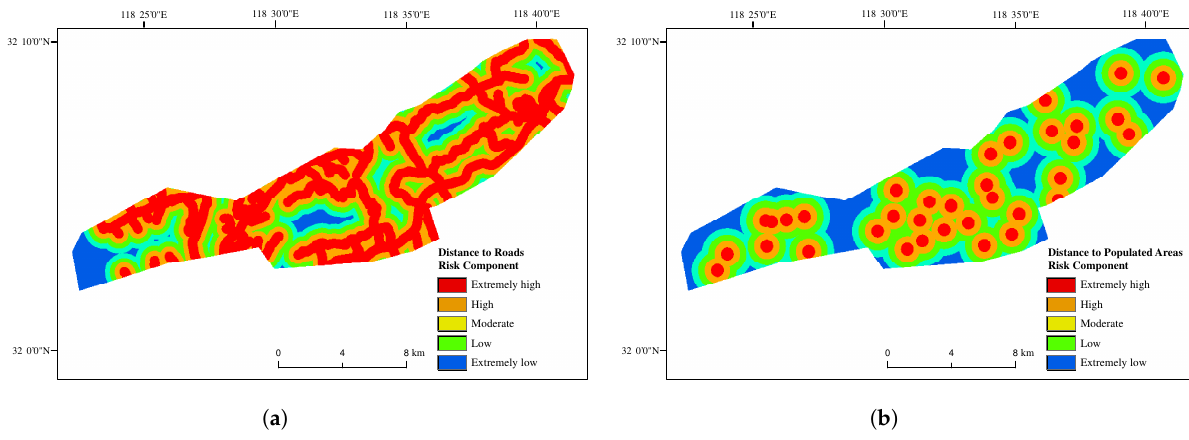
Figure 13. The fire risk map of human activity factors. ( a ) The risk map of distance to roads. ( b ) The risk map of distance to populated areas. The fire risk level of each factor is determined by the fire risk classification